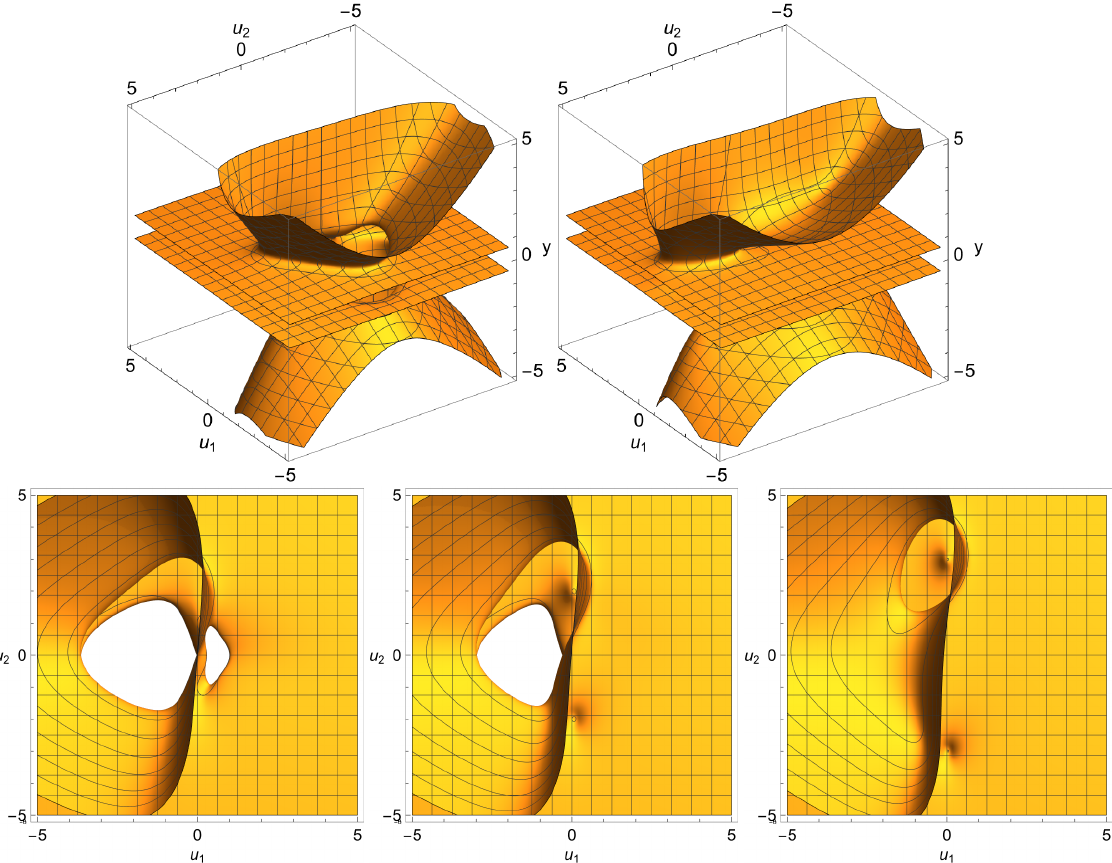
Figure 10. The two figures in the first row (from left to right) show the evolution of the manifold Σ ( 2 ) ( t ) from the asymptotic state ( in ) with data (cid:0) Ω − = 1, ε ( r ) = 1, ε ( i ) = 0.5 (cid:1) to the ( out ) asymp- u 0 (cid:0) Ω + = 3, ε ( r ) = 1, ε ( i ) = 0.5 (cid:1) . The second row represents two-dimensional totic state with data 0 projections of this manifold onto the ( u 1 , u 2 ) plane, showing the evolution of its topological